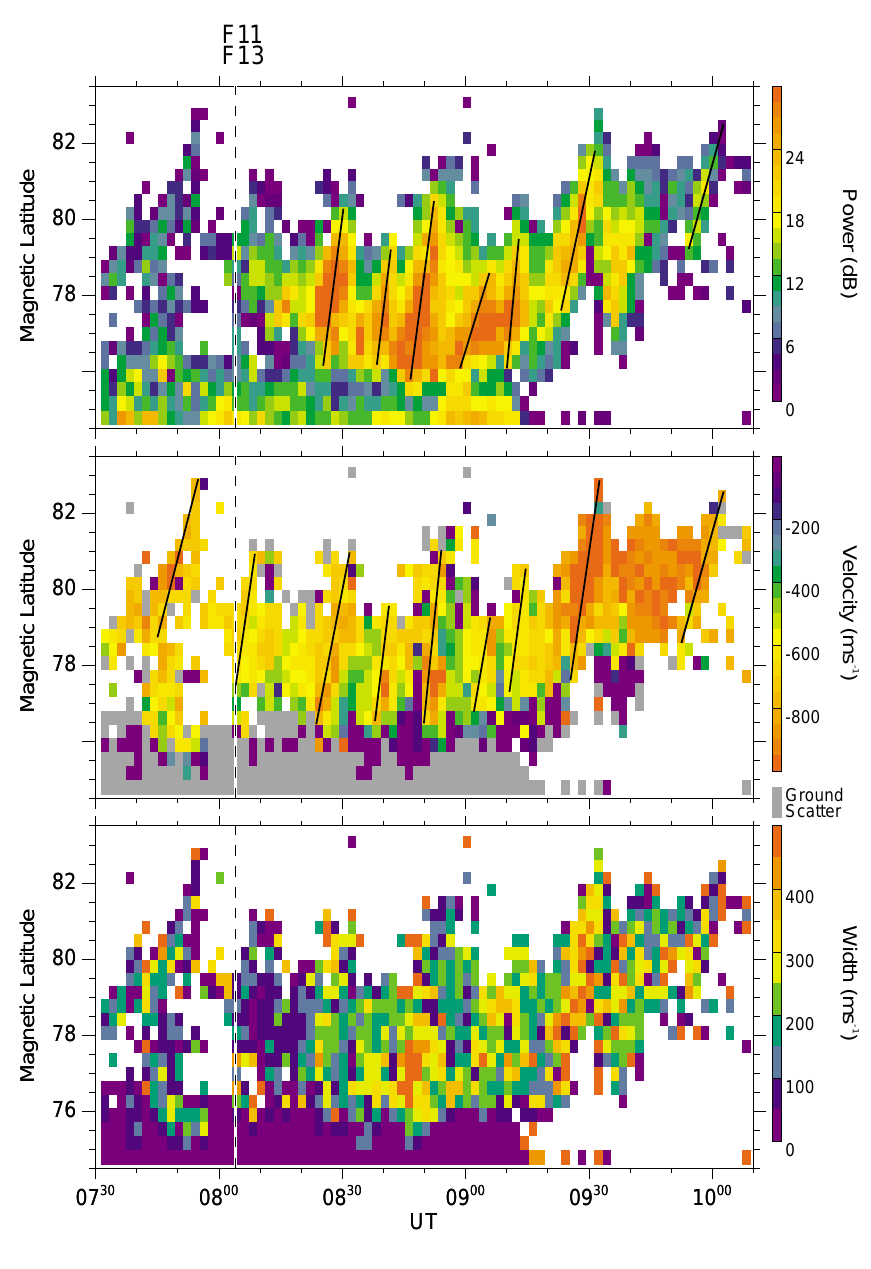
Fig. 1. The backscattered power, line- of-sight (l-o-s) velocity and spectral width observed by beam 4 of the Han- kasalmi radar on the 16 September 1998, 07:30 to 10:10UT. The power is colour-coded, with blue representing the smallest power and red representing the greatest power. The l-o-s velocity is directed away from the radar, with blue indicating the smallest velocity magni- tude and red the largest. The spectral width is also colour-coded with blue indicating the smallest spectral widths and red the